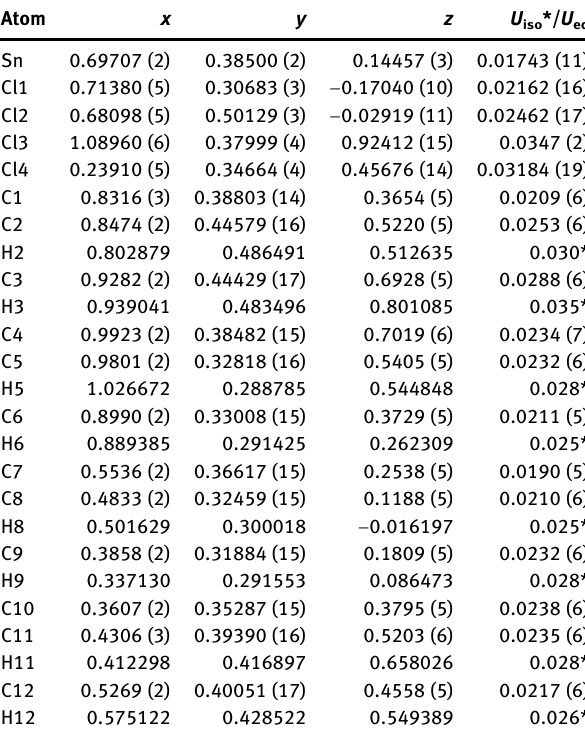
Table  : Fractional atomic coordinates and isotropic or equivalent isotropic displacement parameters (Å  ). Atom